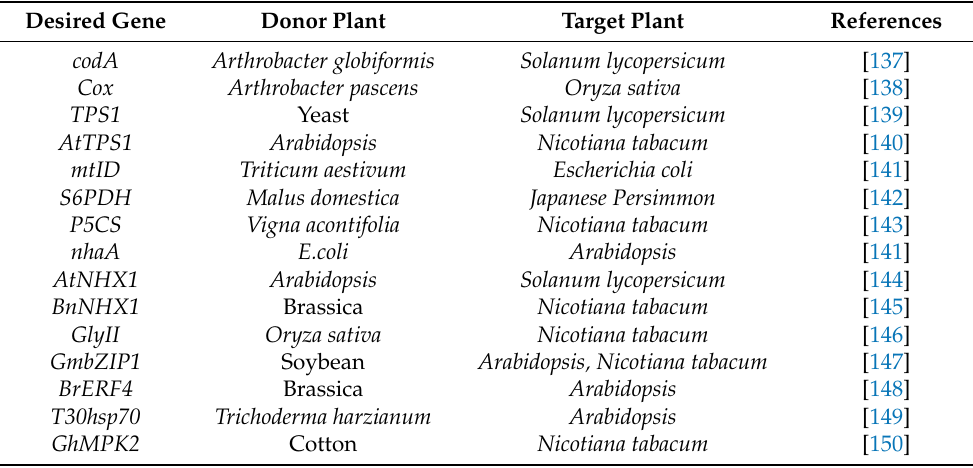
Figure 6. Factors involved in enhanced plant salt tolerance. Table 5. Gene transfer into target plants for enhanced salt tolerance.